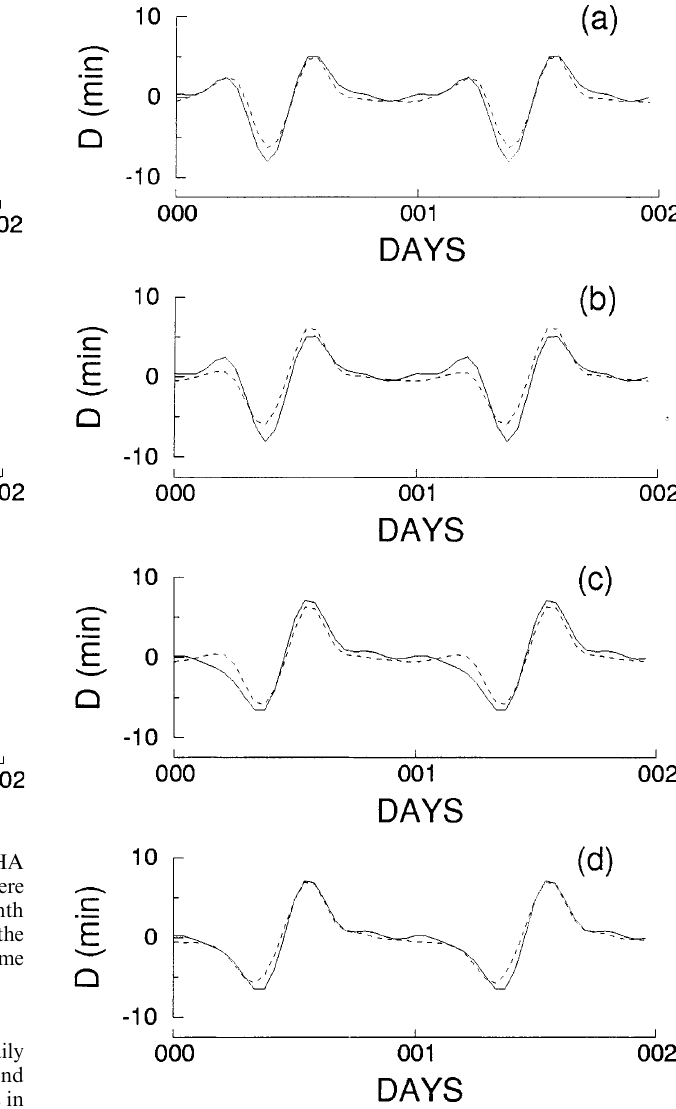
Fig. 4a–d. A comparison of the daily variations determined by HA ( solid curves ) and ANN ( dashed curves ) methods. The ANN was trained using the D-component data from HER for 1993 and 1994. The estimated daily variations for two-day intervals in 1993 are shown, representing the daily variations for a 15 September b 30 September c 1 October and d